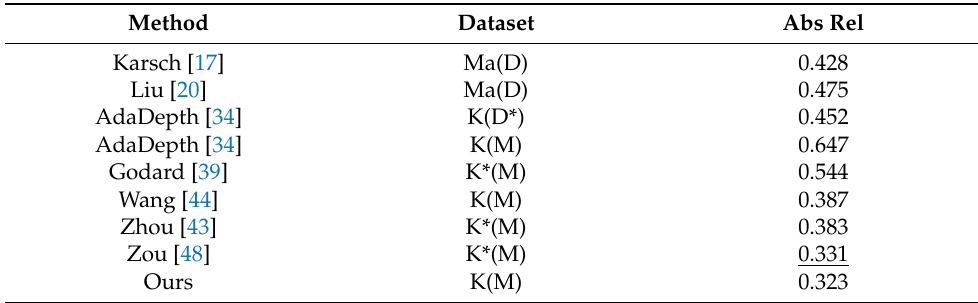
Table 3. Results (Abs Rel) on the Make3D dataset, where “Ma” denotes the model trained on the Make3D dataset, “K*” denotes the model that needs to be pretrained on other datasets, and “D”, ”D*”, ”K” and “M” are the same as in Table